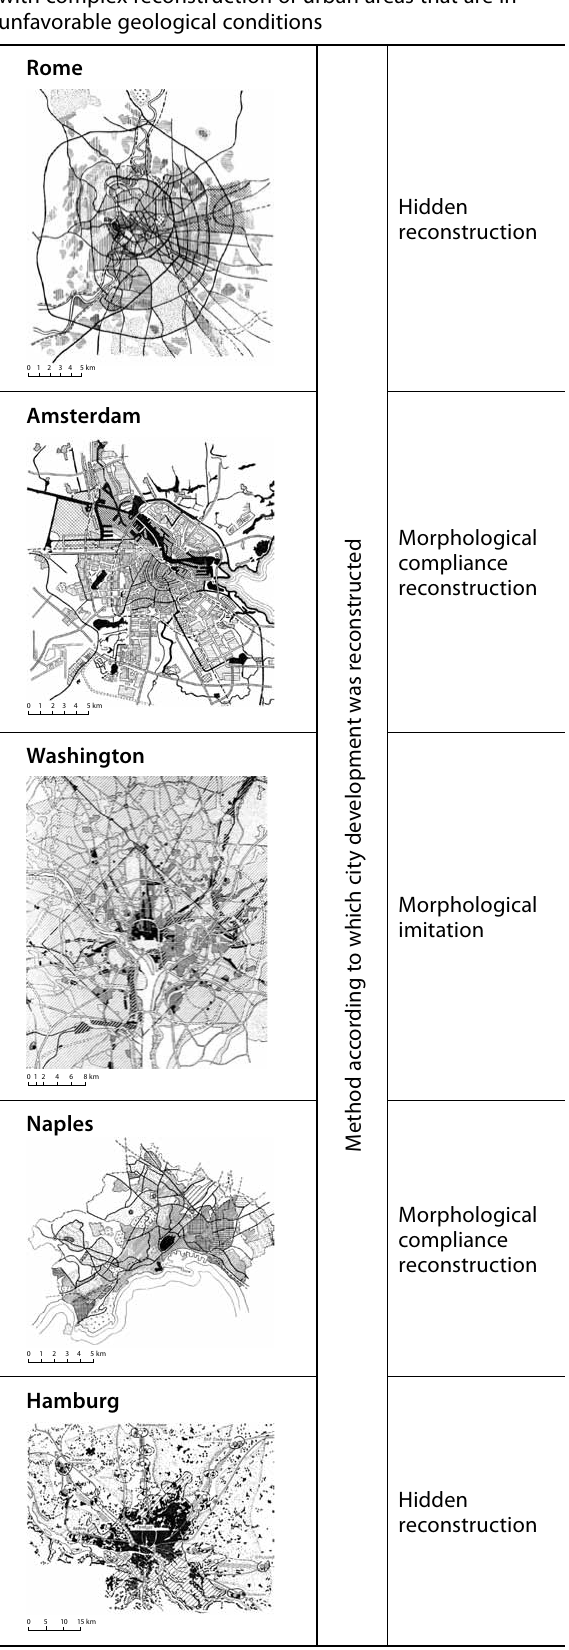
Table 1. Examples of general town planning schemes with complex reconstruction of urban areas that are in unfavorable geological